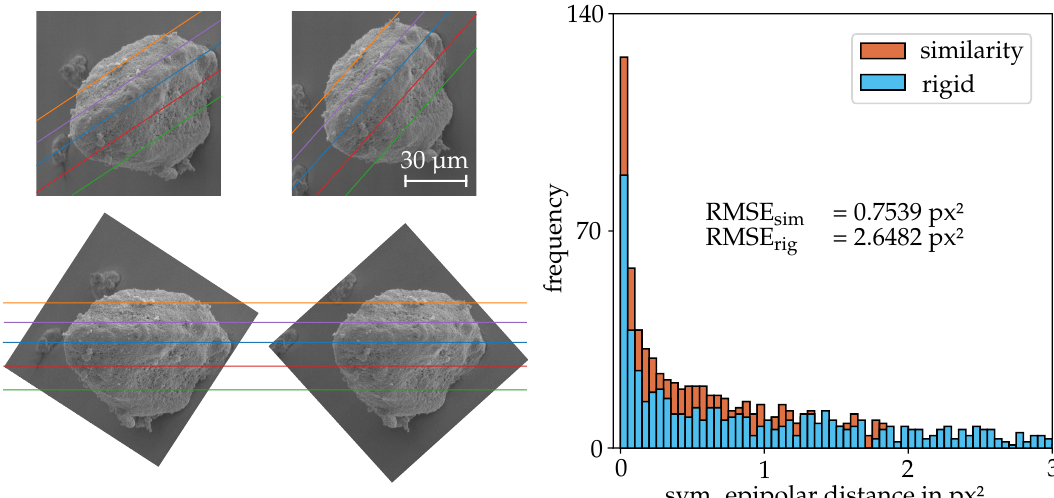
Figure 7. (left) Unrectified and rectified stereo-pair using the similarity transform for the images of a DEP agglomerate (DEP II). (right) Post rectification errors computed for the two different methods in terms of the symmetrical epipolar distances using F R for 463 matches. Table 1. RMSE given as the symmetric epipolar distance in px 2 for the fundamental matrix F R of a rectified stereo-pair. The angle ∆ ϕ S , Y denotes the intended stage tilting difference for each stereo-pair with a manually adjusted scan rotation. ∆ ϕ S , R stands for an additional rotation of the stage in the